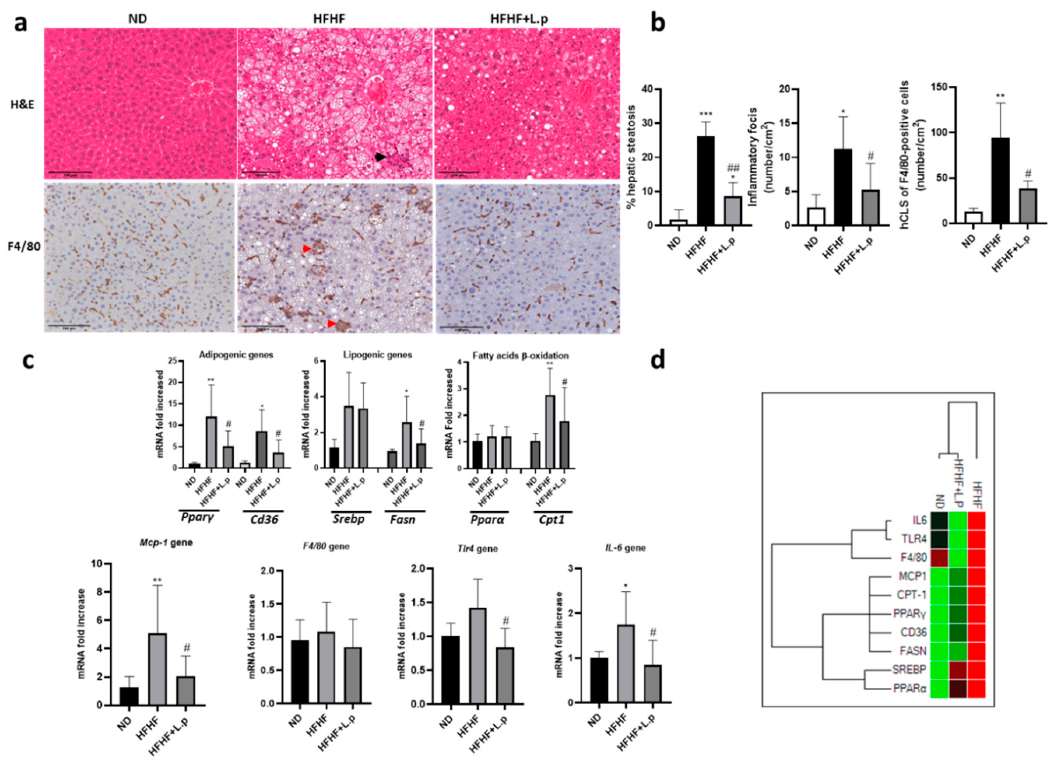
Figure 4. Effect of L.p DSM20174 on liver lipid content and inflammation. ( a ) Images of haematoxylin and eosin (H&E)-stained sections of liver. Black arrowheads indicate lobular inflammation. Representative immunostaining for F4/80. Red arrowheads indicate hepatic crown-like structures (h-CLS). ( b ) Percentage of hepatic steatosis. The number of inflammatory foci per cm 2 . The number of hCLS F4/80 positive cells per cm 2 . ( c ) Fold changes in expression of genes related to adipogenic, lipogenic, fatty acid β -oxidation functions, and liver inflammation. All genes were normalised to expression of RPLPO. ( d ) Hierarchical heatmap clustering of lipid metabolism and inflammatory gene expression in liver mice. Red and green shading represent higher and lower relative expression levels, respectively. Data are expressed as mean ± SEM. * p < 0.05, ** p < 0.01, *** p < 0.001 vs. ND; # p < 0.05, ## p < 0.01 vs. HFHF.